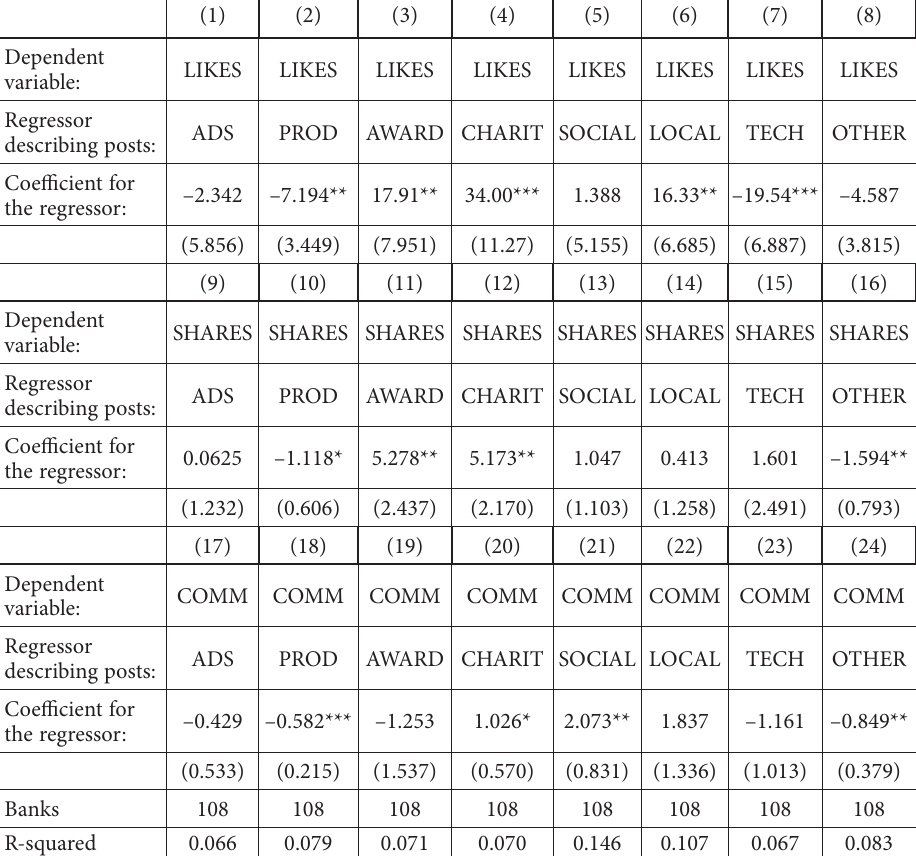
Table 5. Responses to the content of SLBs’ Facebook posts (source: author’s own